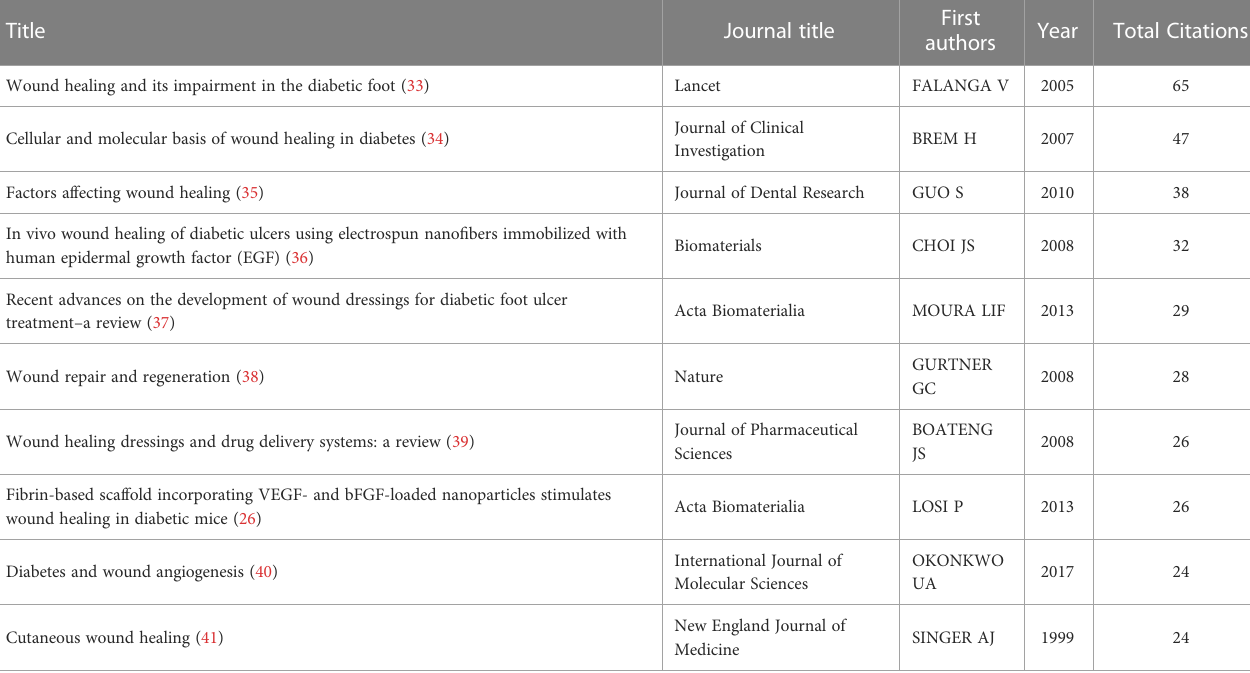
TABLE 6 Top 10 co-cited references in nanomaterials and diabetic wound